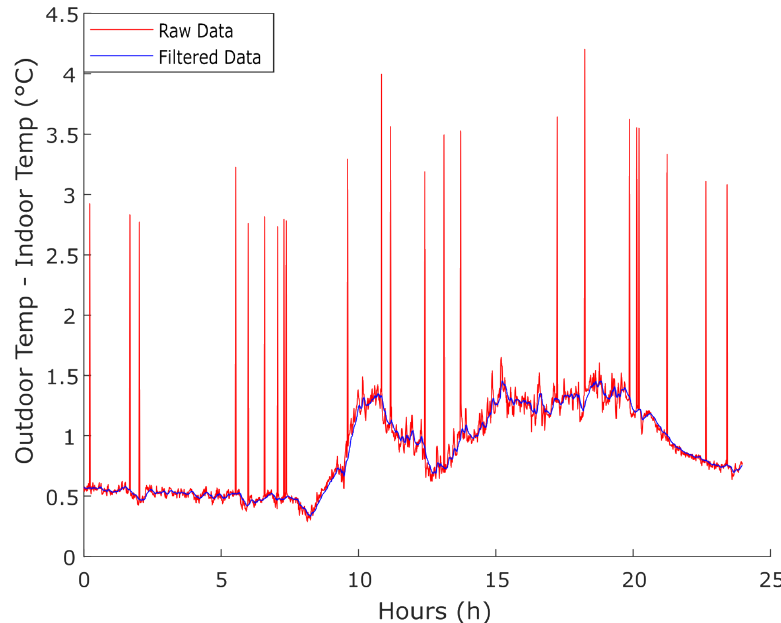
Figure 5. Performance of the outlier and LPF filters over the temperature (i.e., difference of outdoor and indoor temperatures) data